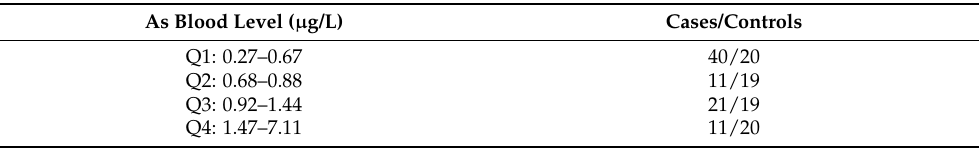
Table 2. CRC occurrence risk associated with As level in blood in women. As Blood Level ( µ g/L) Cases/Controls